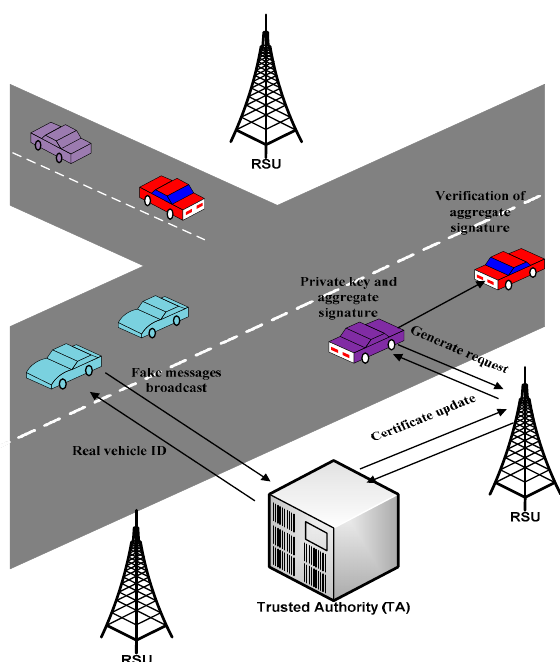
Figure6. Graphicalrepresentation Figure 6. Graphical representation of distributed aggregate privacy-preserving authentication (DAPPA).